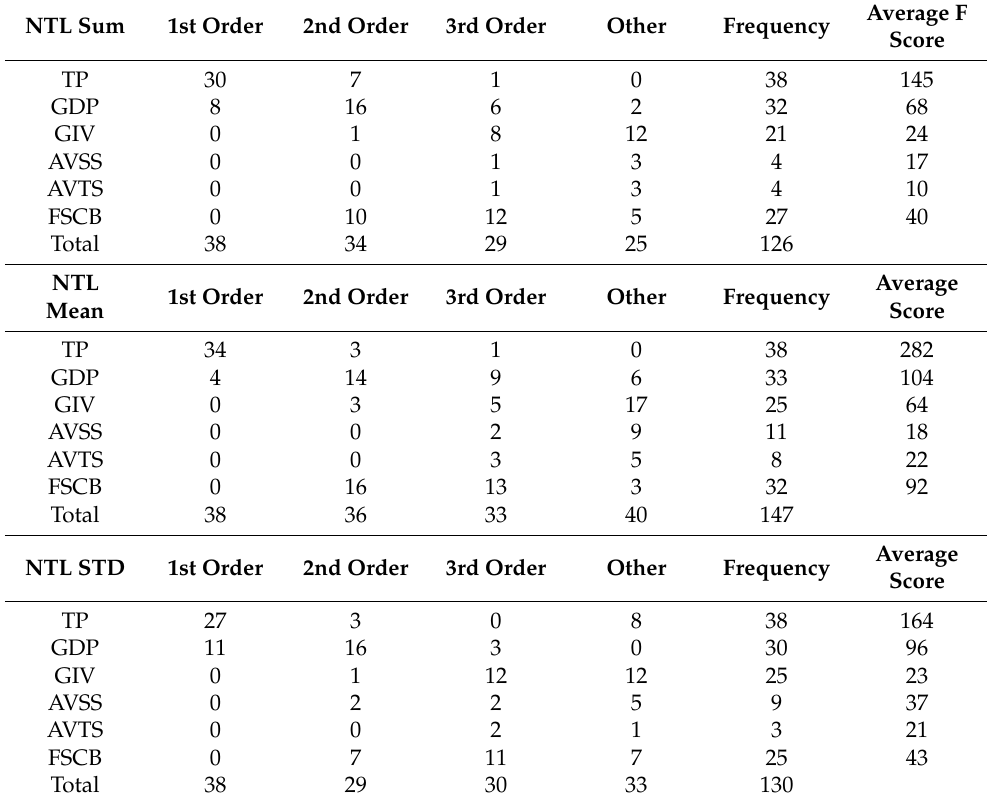
Table 2. DTR factor results for the 38 suburban